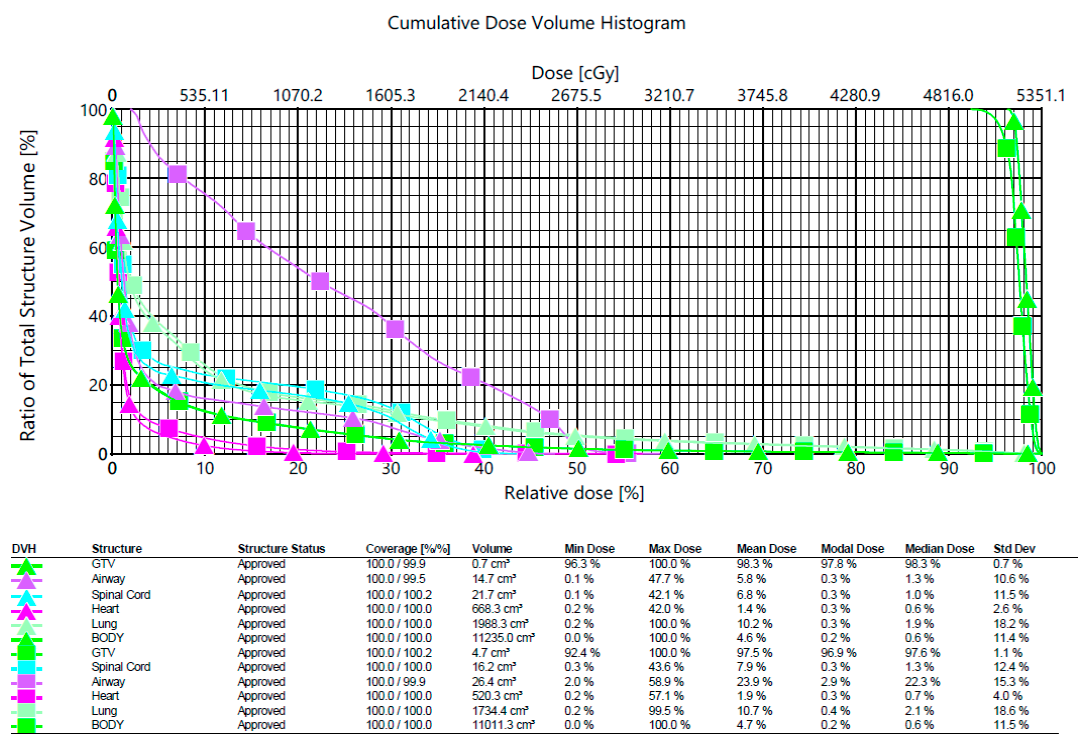
Figure 7. The radiation dose volume histogram. This result was computed by the commercial product (Eclipse) with the contour segmentation ready. The triangle marks denote the physician’s manual segmentation result, whereas the square marks denote the segmentation result by our system.